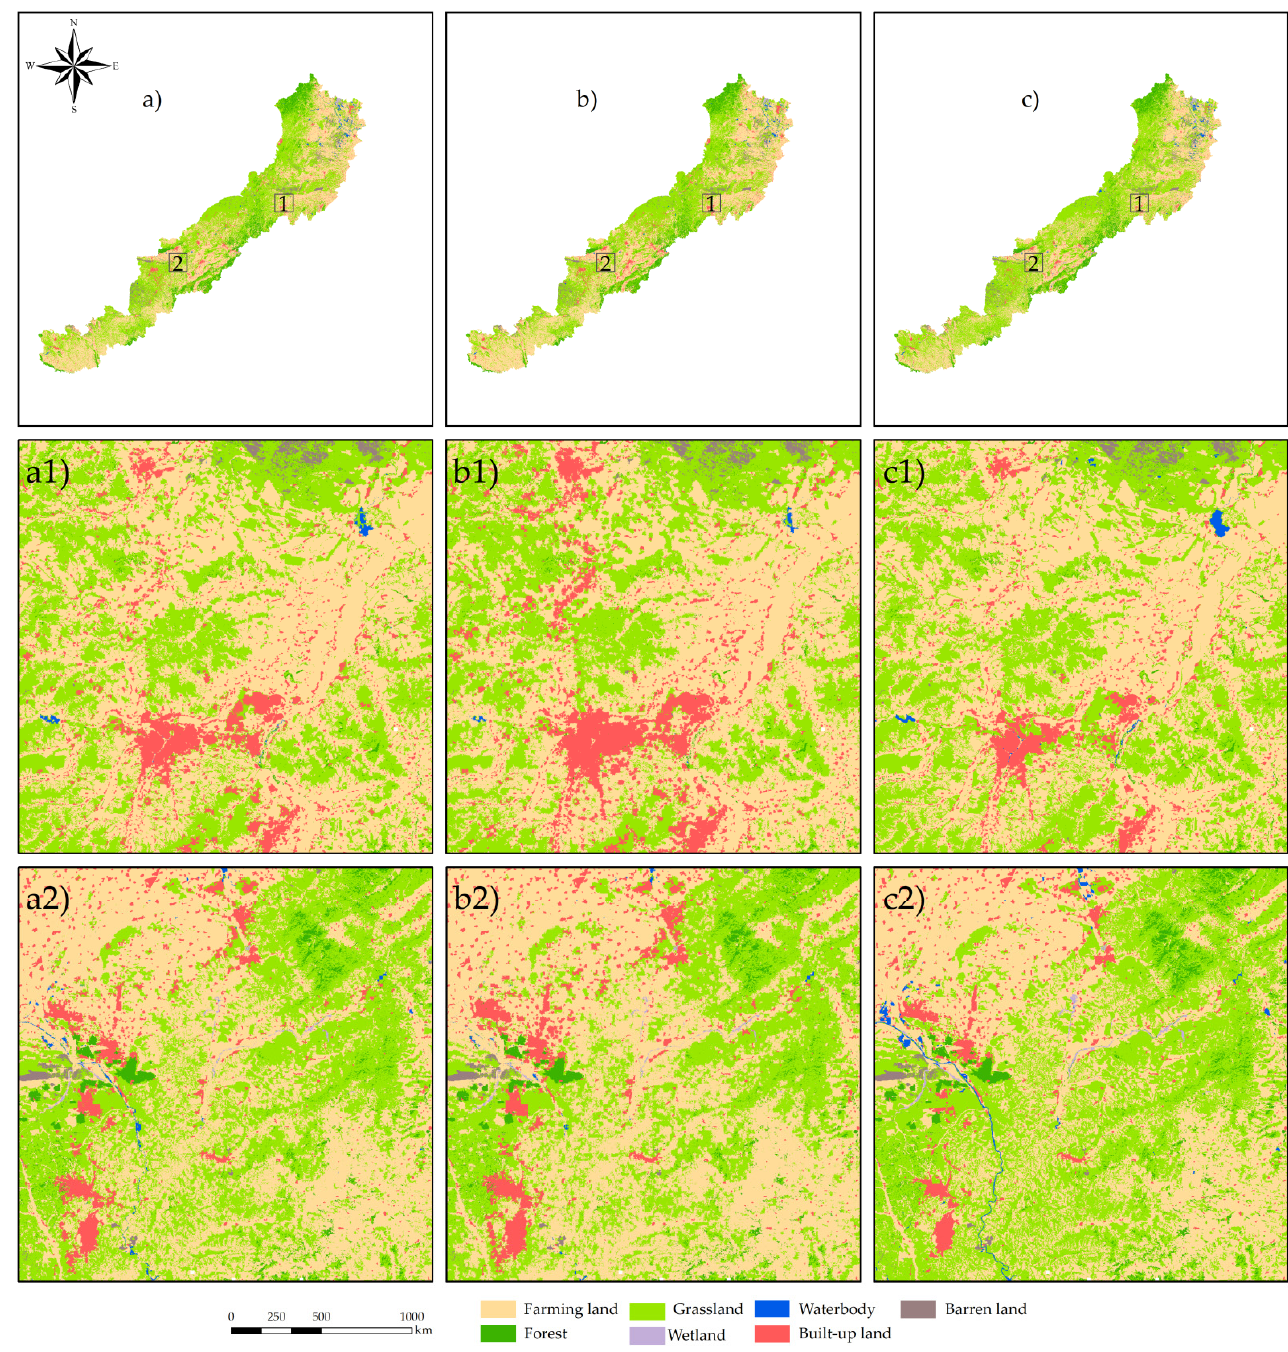
Figure 5. Land-use patterns in 2030 under three scenarios: ( a ) BAUS; ( b ) EDS; ( c ) EPS; with ( a1 – c2 ) detailed simulation results.